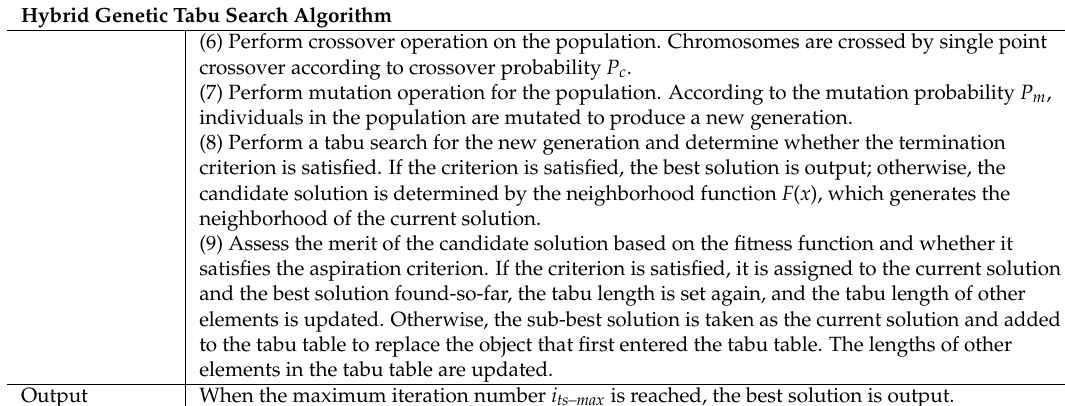
Hybrid Genetic Tabu Search